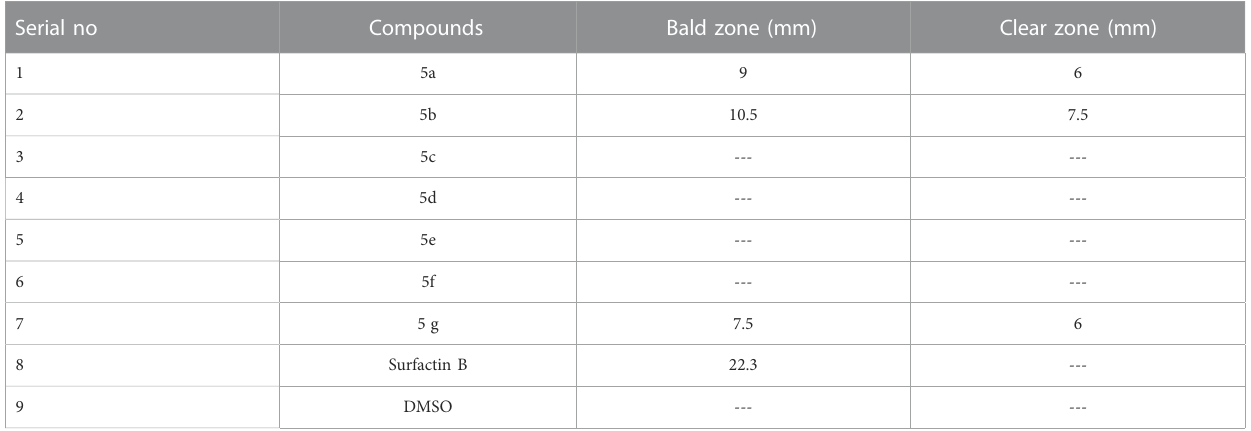
TABLE 5 Protein Kinase inhibitory potential of compounds